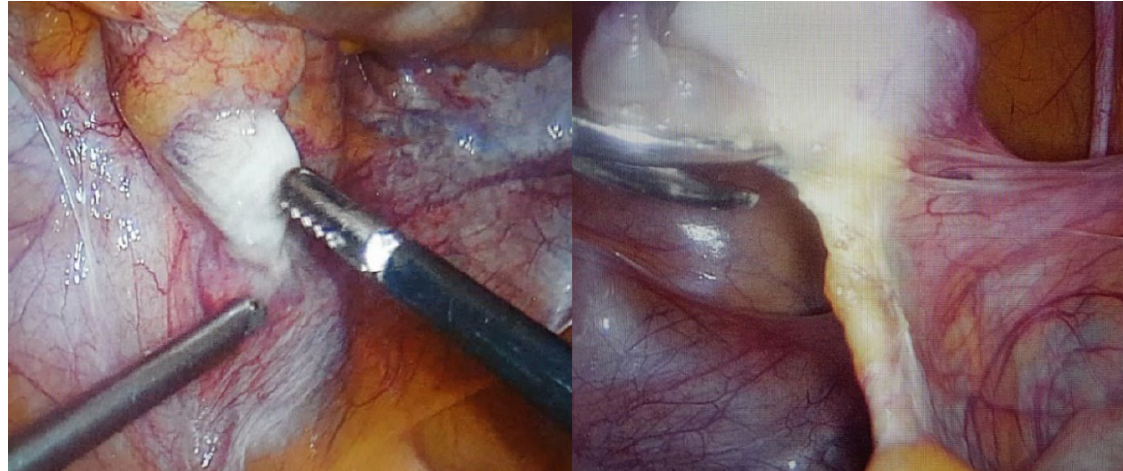
Figure 2. Intraoperative photography of the left and right gonads.